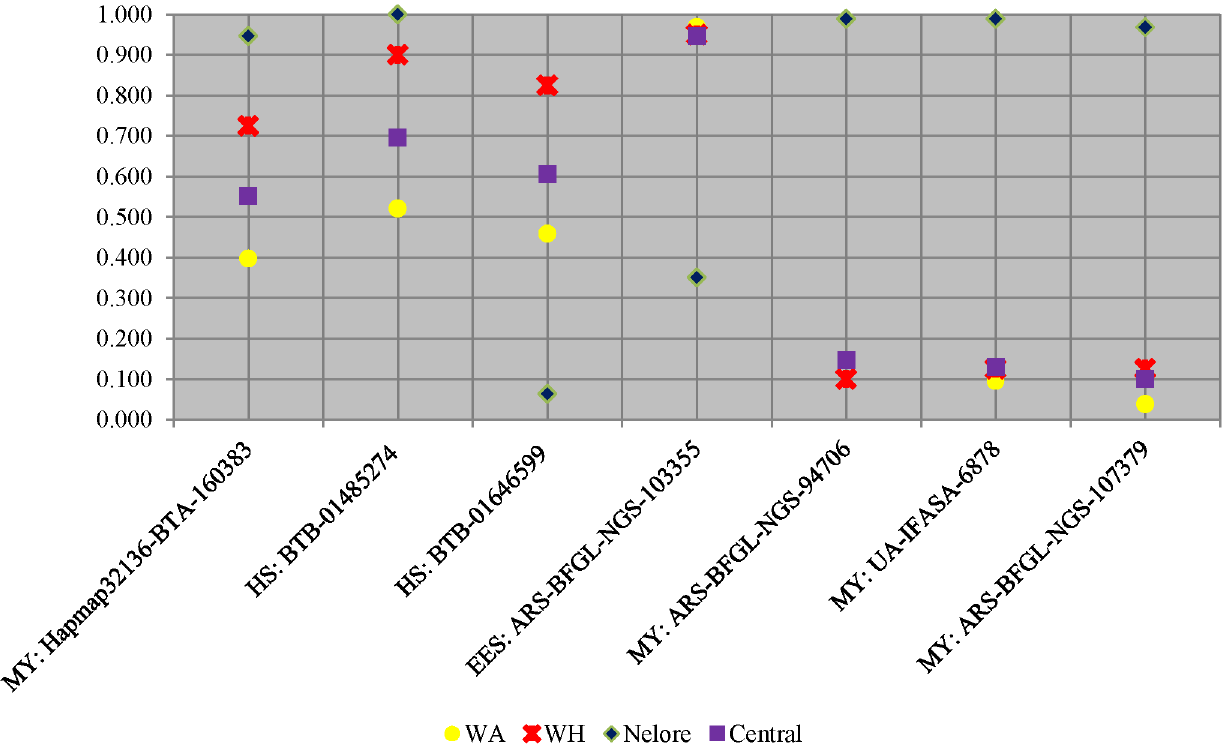
Fig 6. TreeSelect adjusted allele frequencies for SNPs associated with production or adaptation to environmental stress for warm arid (WA), warm humid (WH) ecoregions, and Nelore. The prefix to SNP name describeseach SNP’s reportedfunction: early embryonic survival (ESS), heifer conceptionrate (HCR), heat stress (HS), and milk yield